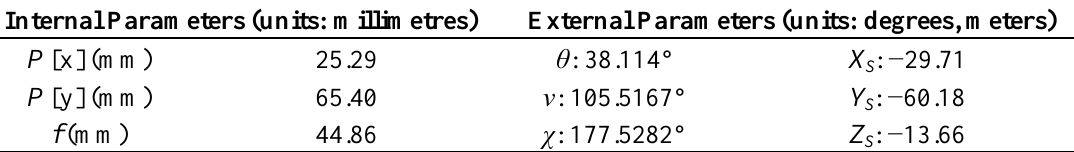
Table 3. Internal and external parameters of the unknown